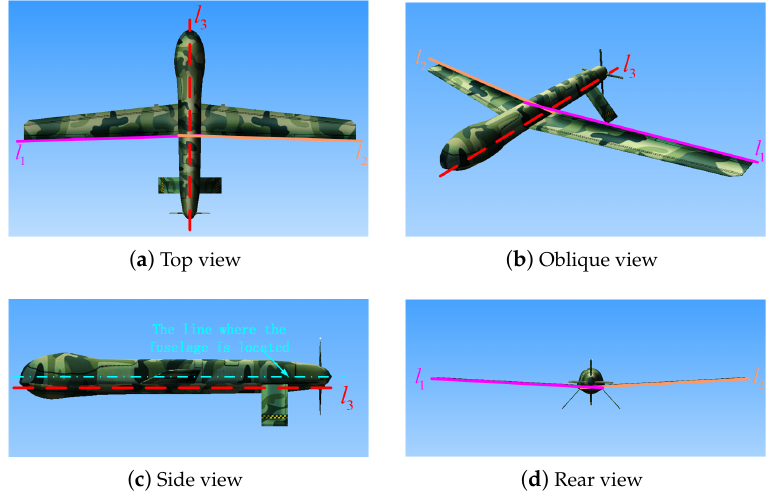
Figure 4. Schematic diagram of aircraft attitude